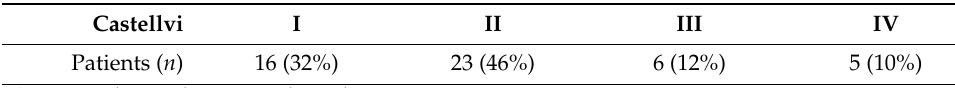
Table 2. Classification of patients with LSTV, according to the Castellvi. Castellvi I II III IV Patients ( n ) 16 (32%) 23 (46%) 6 (12%)